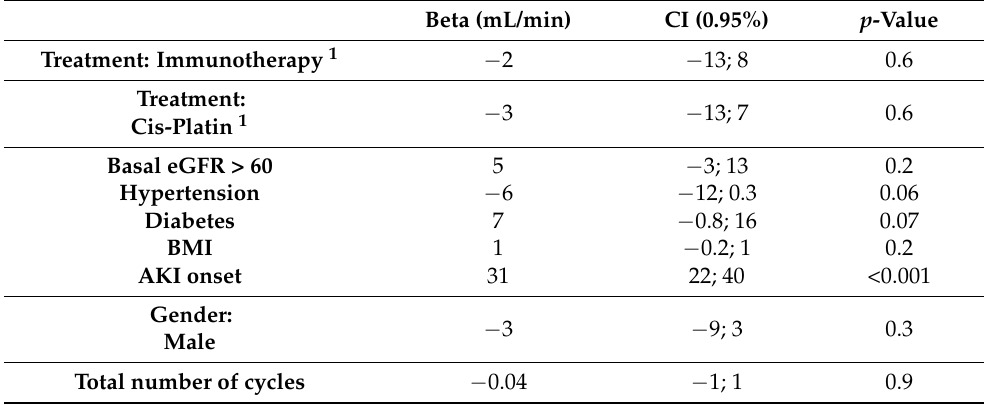
Table 5. Multivariable linear regression for eGFR decay (basal–final). 1 : reference level treatment: carboplatin.